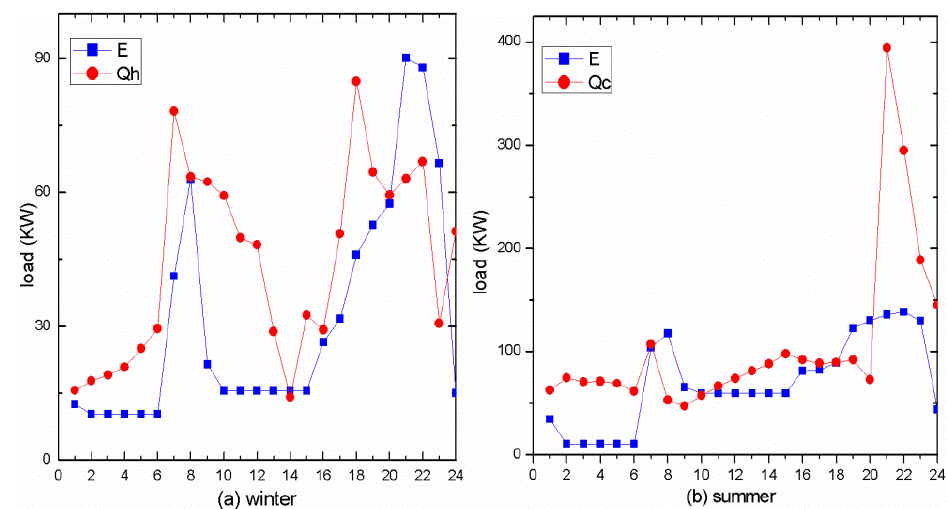
Figure 4. The simulated daily energy demands based on DeST software in representative ( a ) winter and ( b ) summer